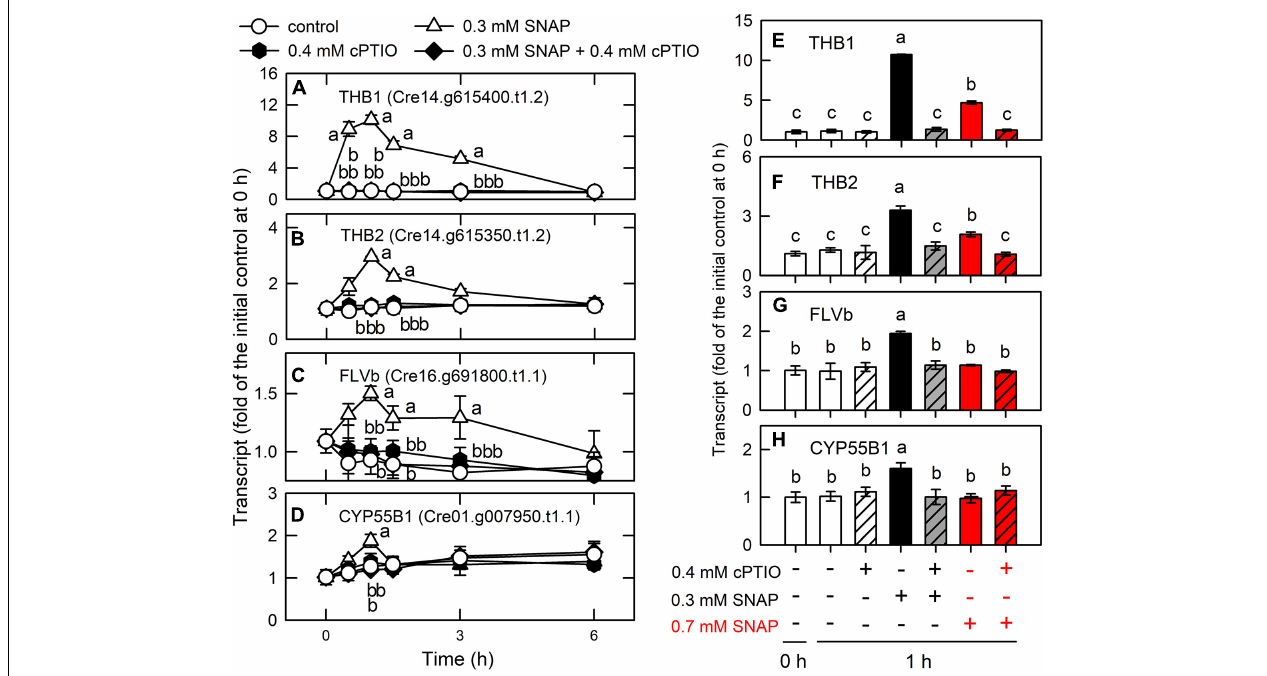
FIGURE 10 | Effects of NO on the expression of genes encoding NO scavenging proteins. Time-course changes in the transcript abundances of THB1 (A,E) , THB2 (B,F) , FLVB (C,G) , and CYP55B1 (D,H) in C. reinhardtii after exposure to 0.3 or 0.7 mM SNAP in the presence or absence of 0.4 mM cPTIO. The transcript abundances for 0.7 mM SNAP treatment are determined at 1-h samples. Data are expressed as the mean ± SD ( n = 3). Different symbols indicate significant differences between treatments (Scheffde’s test, P <